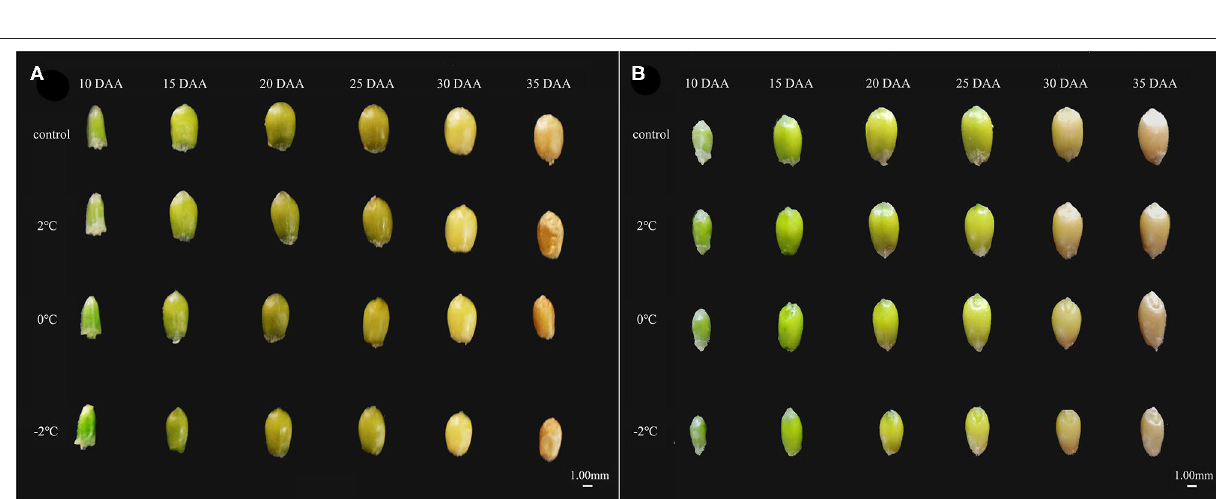
Frontiers in Plant Science | www.frontiersin.org